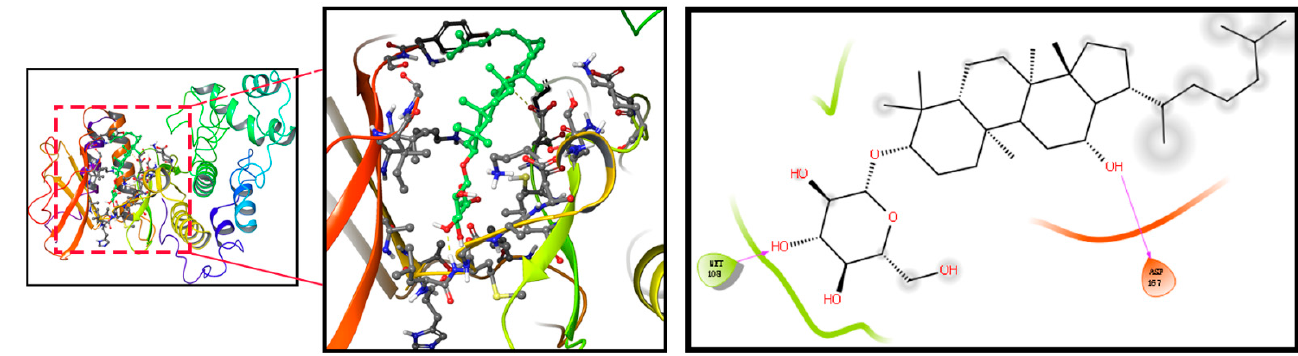
Figure 4. Molecular docking simulation results for Rh3 with ERK.